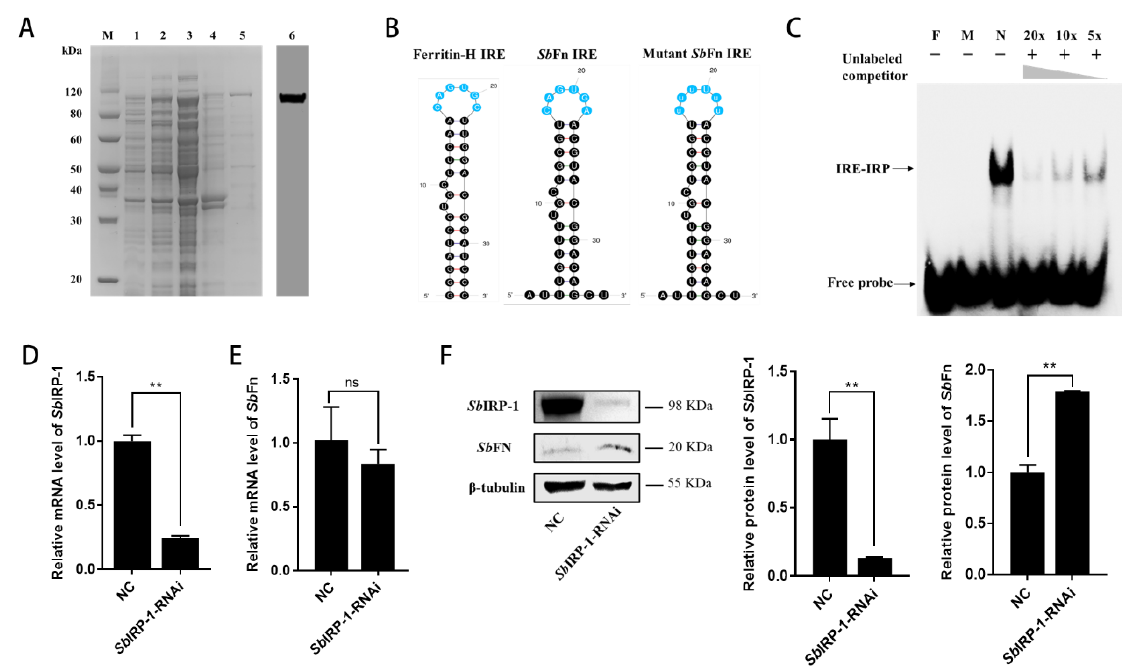
Figure 6. The regulatory role of Sb IRP-1 on the translation of Sb Fn. ( A ) The recombination protein of Sb IRP-1 and specificity of its polyclonal antibody. M: protein marker; Lane 1: BL21 harboring pET-28a- Sb IRP-1 (without induction); Lane 2: IPTG-induced BL21 harboring pET-28a- Sb IRP-1; Lane 3: supernatant of IPTG-induced bacteria lysate; Lane 4: precipitation of IPTG-induced bacteria ly- sate; Lane 5, purified r Sb IRP-1; Lane 6, Western blot analysis of hemocyte lysates using Sb IRP-1 polyclonal antibody. ( B ) Putative structures of consensus iron response elements (IREs) located on